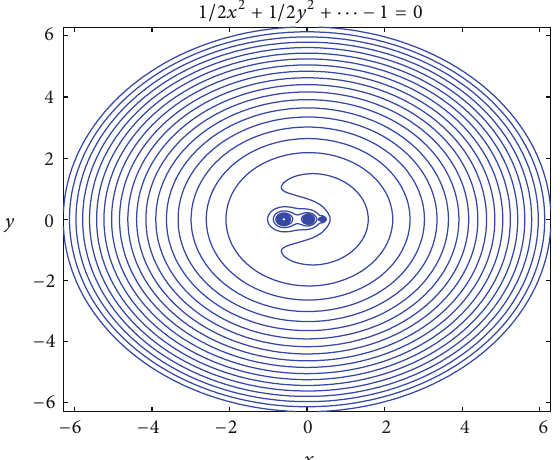
Figure 17: Curve of zero velocity (Kruger60-3) 𝑞 1 = 0.99998 , 𝑞 2 = = 0.1 , 𝐴 = 0.2 . 0.99996 , and 𝐴 1 2